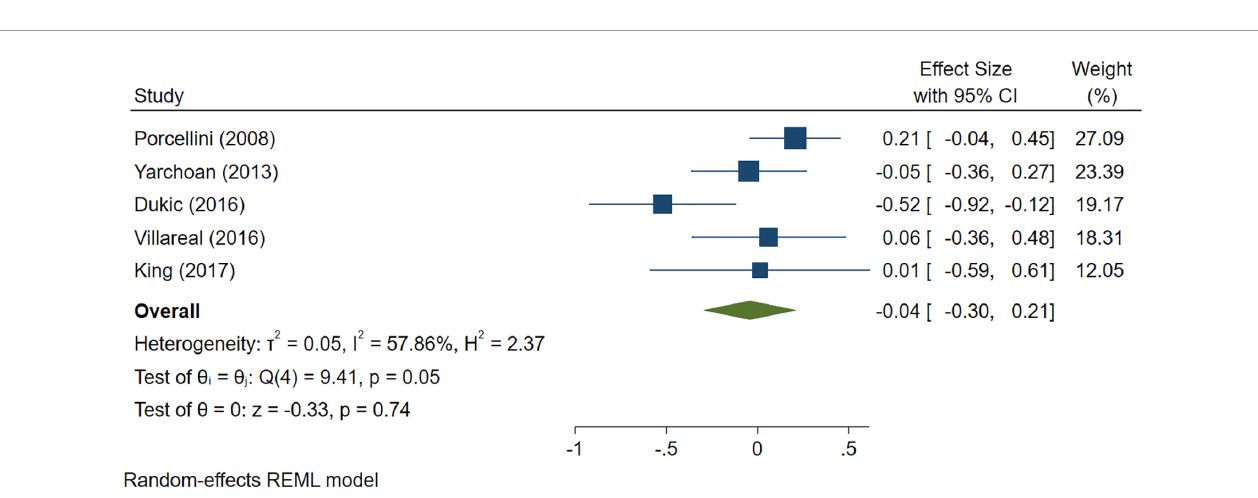
FIGURE10 Forest plot of pooled Hedge’s g depicting high C-reactive protein (CRP) concentration in mild cognitive impairment (MCI) samples compared to